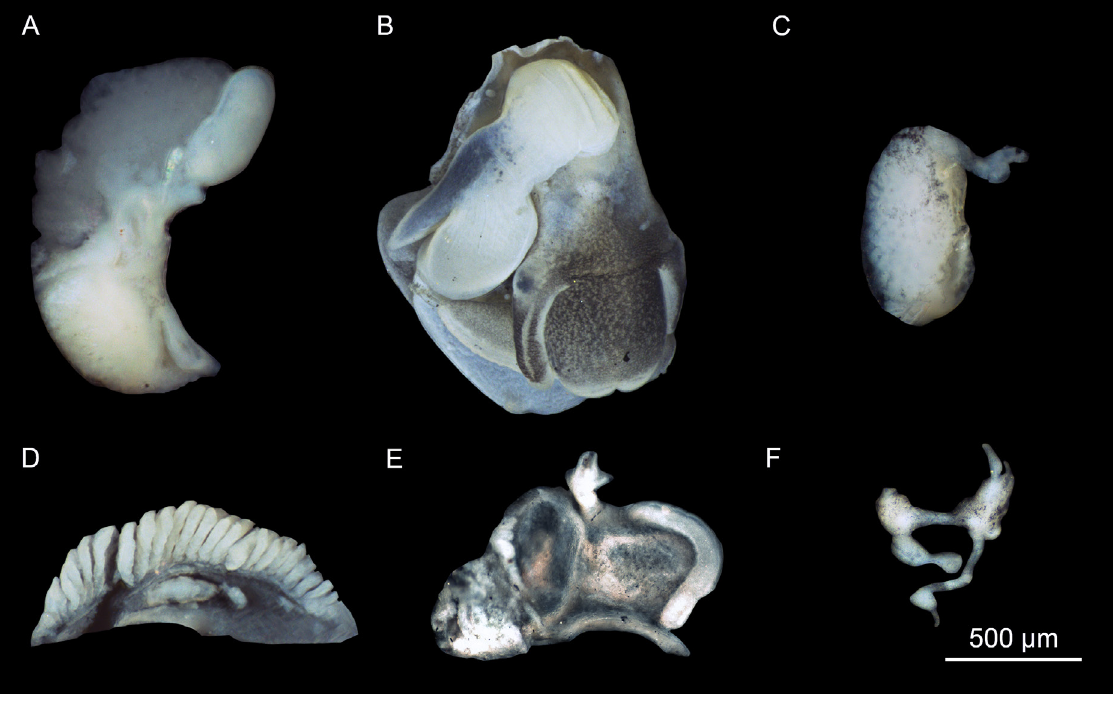
Fig. 13. Anatomy of Mercuria balearica (Paladilhe, 1869) . A , D , F . Stream at Sant Joan de